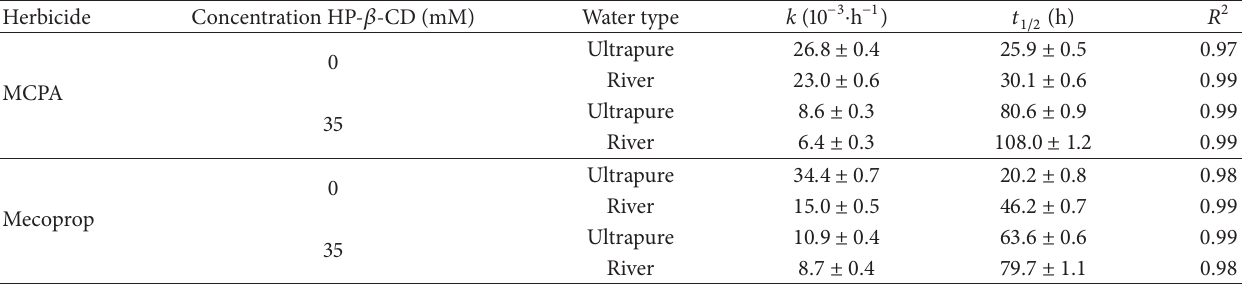
Table 2: Kinetic parameters of MCPA and mecoprop photodegradation in different aqueous